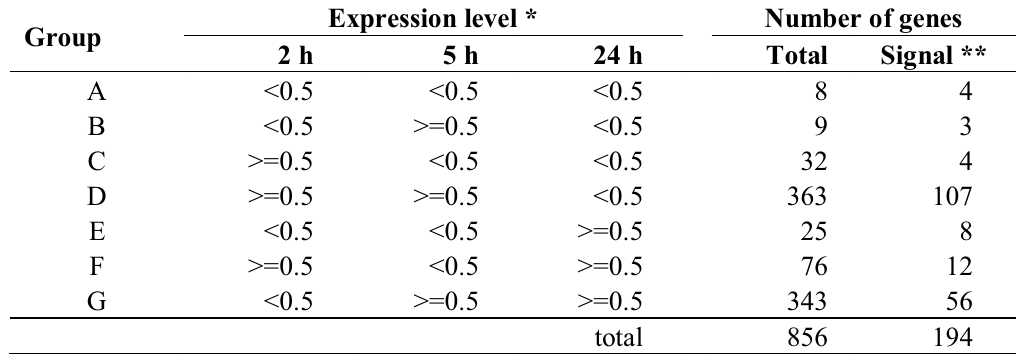
Table 6. Classification of genes whose expression was repressed at acidic